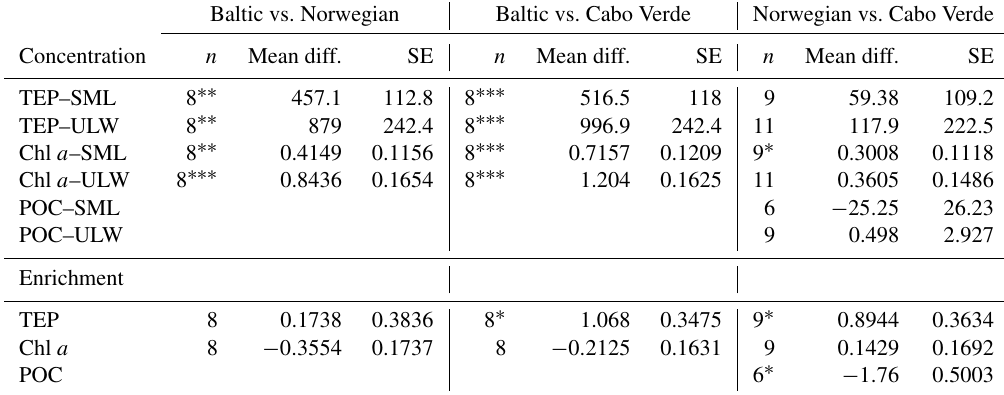
Table 4. Regional comparison of TEP, Chl a and POC enrichment and concentrations. ∗ p <0.05 analysed using ANOVA Tukey statistical test (95% confidence interval). POC data from the Baltic Sea were excluded due to low n values. Baltic vs. Norwegian Baltic vs. Cabo Verde Norwegian vs. Cabo Verde Concentration n Mean diff. Mean